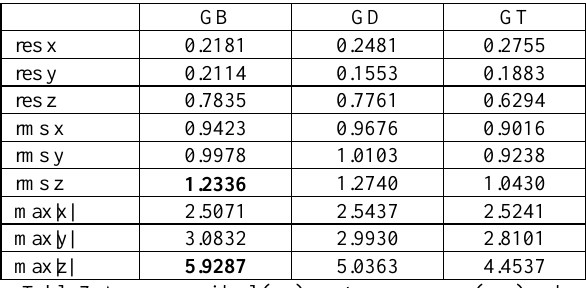
Table 7: Average residual (res), root mean square (rms) and maximal absolute residual value (max|v|) of all check points in mm (7MB dunk) after removing the sequences containing errors.